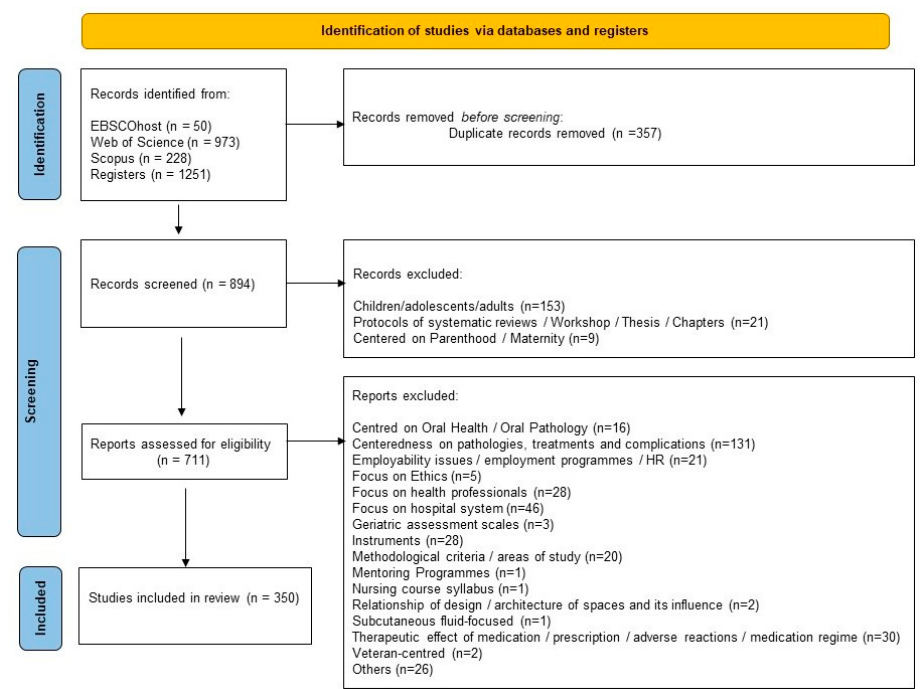
Figure 1. PRISMA 2020 flow diagram.